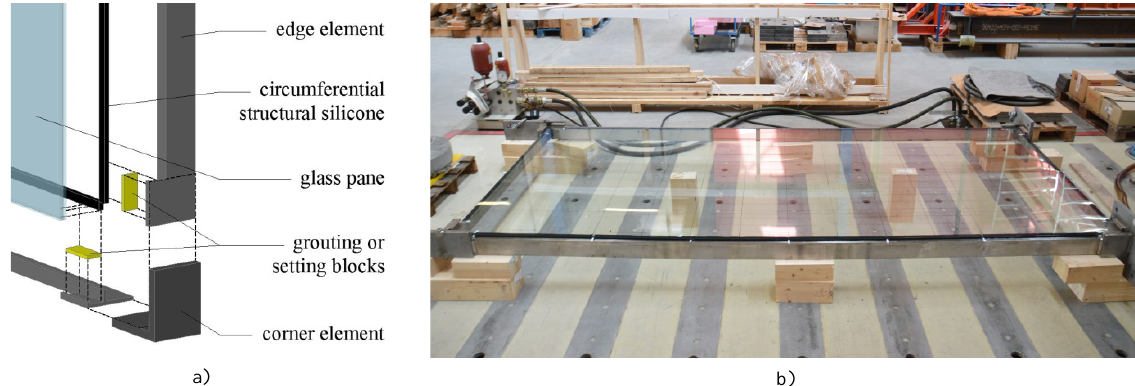
Fig. 1 Proposed glass-metal elements with composite structural behavior: a) conceptual sketch of the corner area and b) large-scale test specimen after manufacturing.